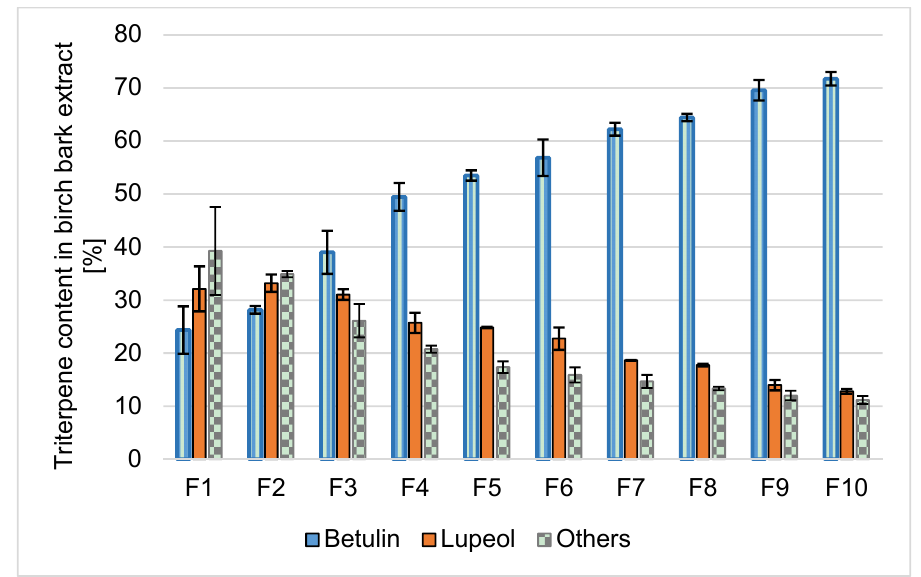
Figure 4. Triterpene composition of fractional RESS extracts; n = 2–3, mean ± SD or span width.